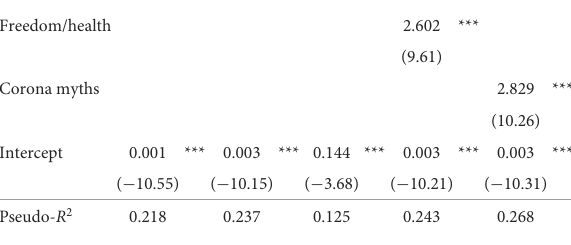
The table shows the results from binary logistic regressions of Corona denial on socio- political characteristics and various attitudes ( N = 1,280). The presented coefficients are odds-ratios with z -scores in brackets. Significance of the estimates in two-sided tests: * p ≤ 0.10, ** p ≤ 0.05, *** p ≤